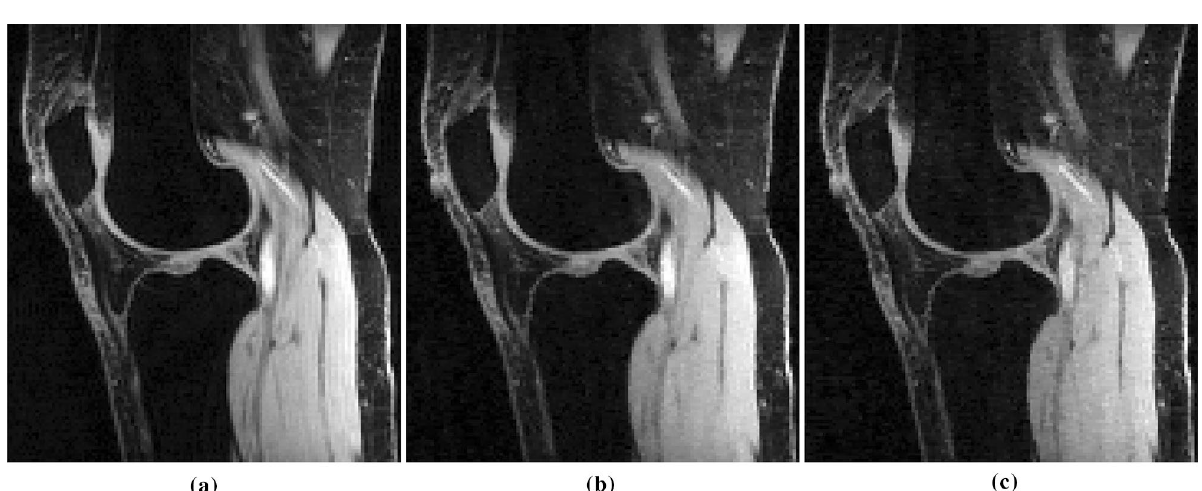
Figure 11. Comparison of ( a ) fully sampled parallel MRI (2 min 46 s scan time) with prospective accelerated parallel MRI at AF = 4 (42 s scan time) using ( b ) optimized SP and ( c ) Poisson disk considers measurements for specific anatomy and assumes a specific reconstruction method. Our experiments show that the optimized SPs are different for different reconstruction methods, suggesting that matching the sampling to the reconstruction method is important. The approach improves the acceleration factor and helps with finding the best SP for reconstruction methods in various applications of parallel MRI.